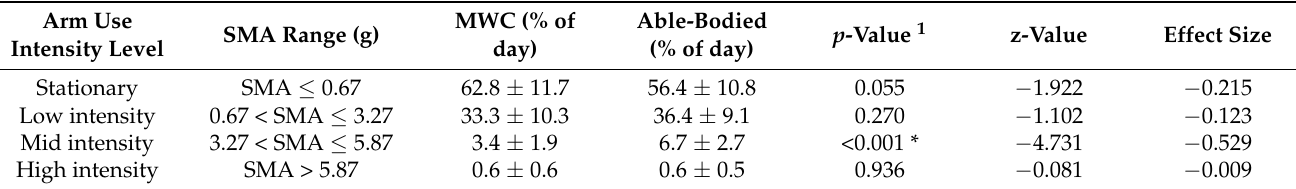
Table 3. The defined in-lab signal magnitude area (SMA) range for each arm use intensity level and the mean ± standard deviation percentage of the day the dominant arm of the manual wheelchair users (MWC) and able-bodied individuals spent in each arm use level in the free-living